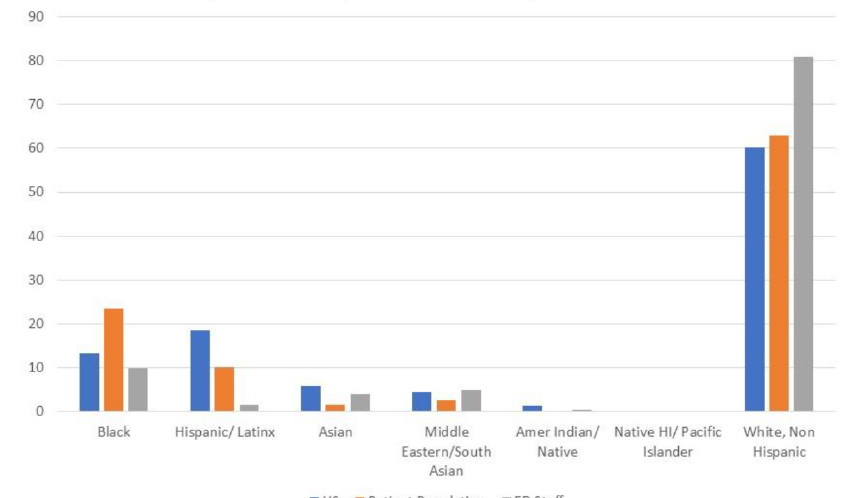
Figure 1. Comparison of population to staff representation by percentage. HI , Hawaiian; ED , emergency department.